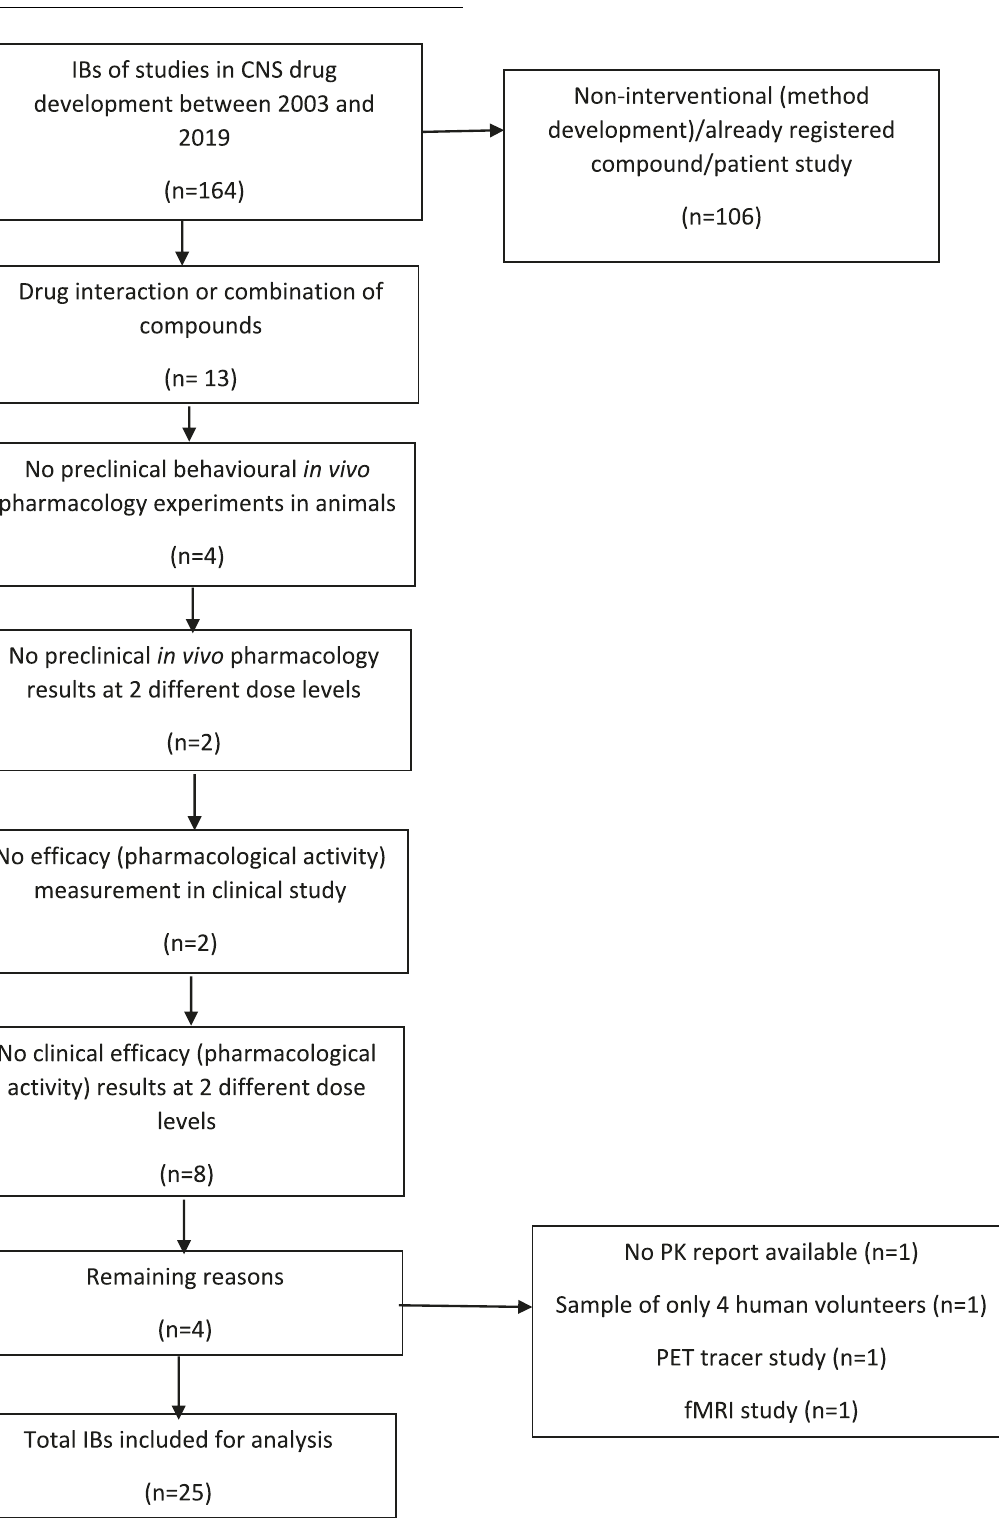
effects at values below the NOAEL was similar for all three exposure parameters.